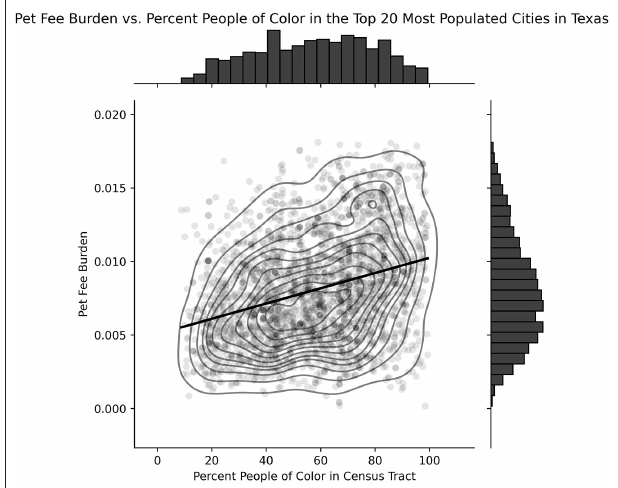
FIGURE 1 | Relationship between pet fee burden and proportion of people of color by census tract. A significant positive relationship is present between the pet fee burden of a census tract’s housing and the percent of people of color in that tract ( F = 31.76, R 2 = 0.10 and P < 0.001).